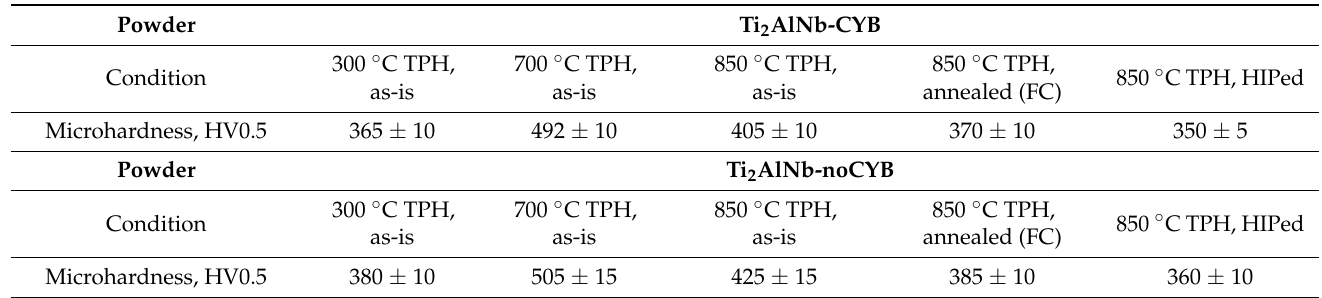
Table 4. Microhardness of the samples fabricated using Ti2AlNb-CYB and Ti2AlNb-noCYB powders by L-PBF process with different preheating temperatures (TPH) and post-processing.